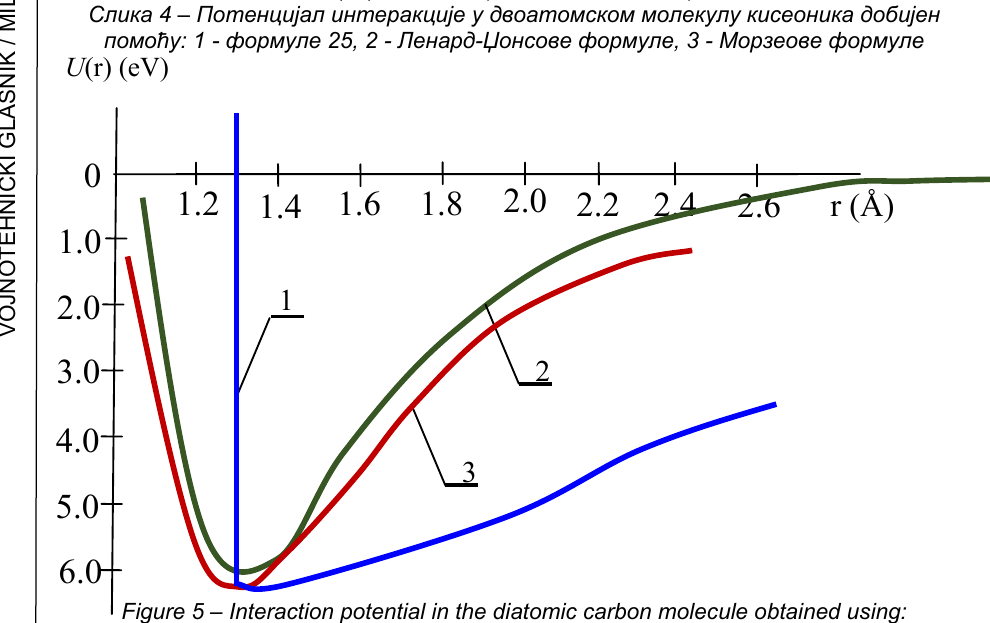
Figure 5 – Interaction potential in the diatomic carbon molecule obtained using: 1 - formula (25); 2 - Lennard-Jones formula; 3 - Morse formula Рис . 5 – Потенциал взаимодействия в двухатомной углерода полученный